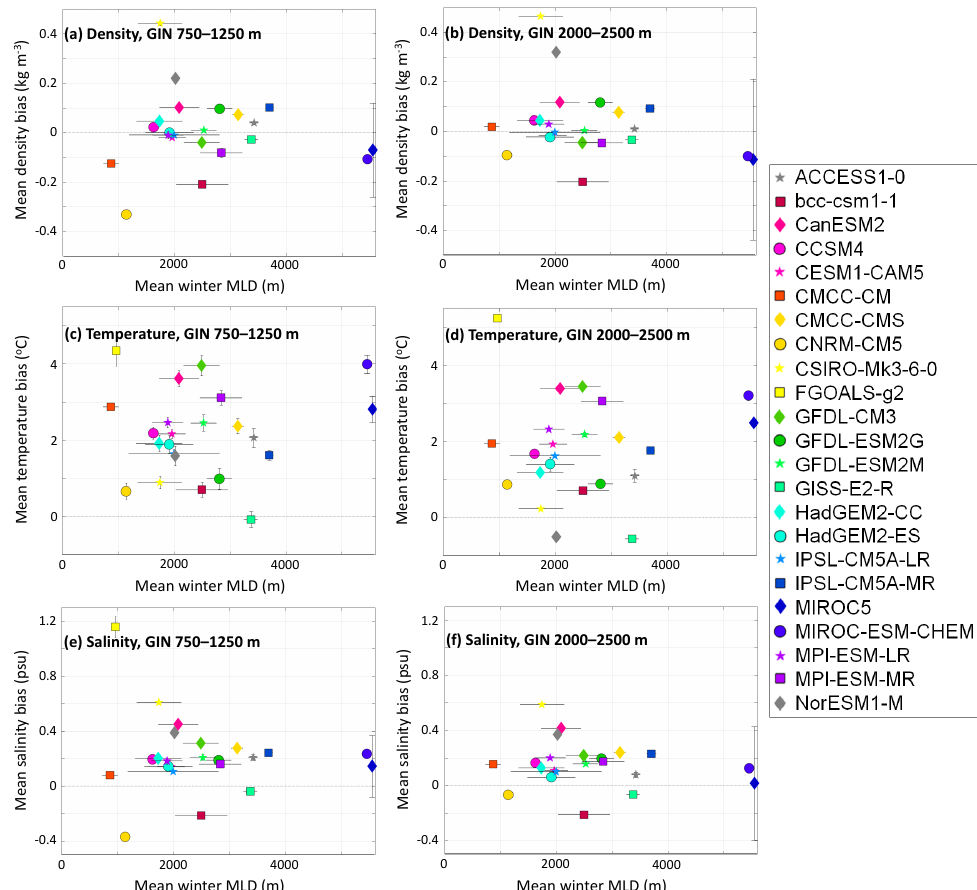
Figure 3. Same as Fig. 2 but for the GIN